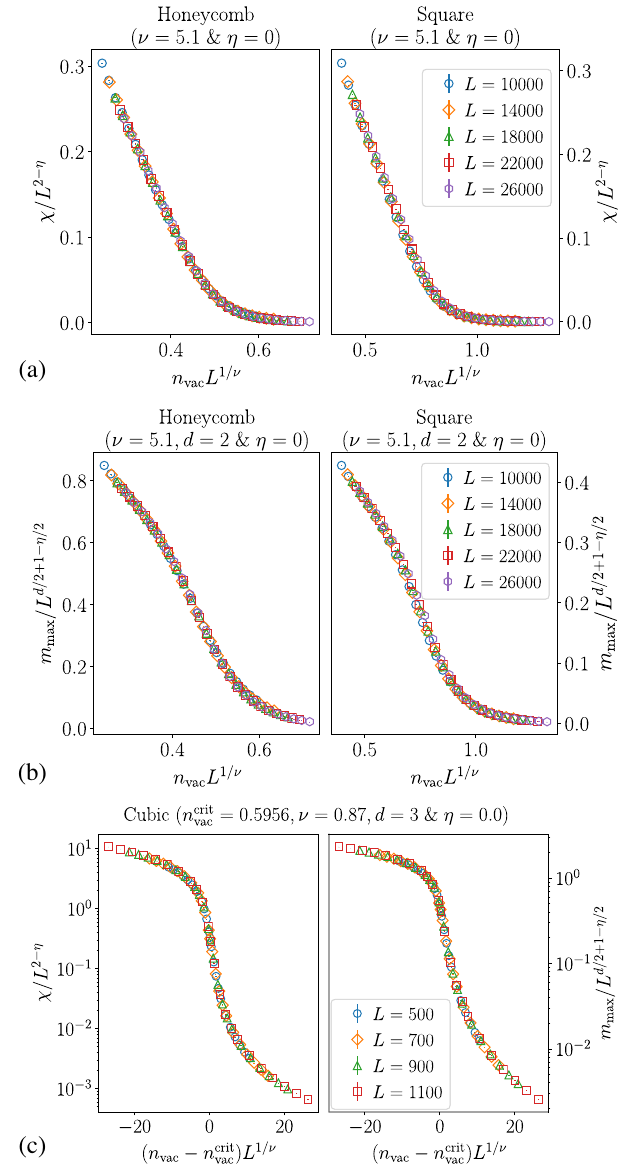
FIG. 14. In panels (a) and the left panel of (c), for appropriate dimension-dependent choices of ν and η , the susceptibility χ associated with the sample-averaged geometric correlation func- tion C ð r − r 0 Þ in two-dimensional L × L samples [three-dimen- sional L × L × L samples], when rescaled by L 2 − η , collapses onto L 1 = ν a single curve when plotted as a function of n vac − n crit Þ L 1 = ν ] for small n [ ð n [for n close to n crit ]. In vac vac vac vac vac panels (b) and the right panel of (c), m , the sample-averaged max mass of the largest R -type region in two-dimensional L × L samples (three-dimensional L × L × L samples), when rescaled by L d= 2 þ 1 − η = 2 with d ¼ 2 (with d ¼ 3 ), shows analogous scaling behavior. See Sec. VII for